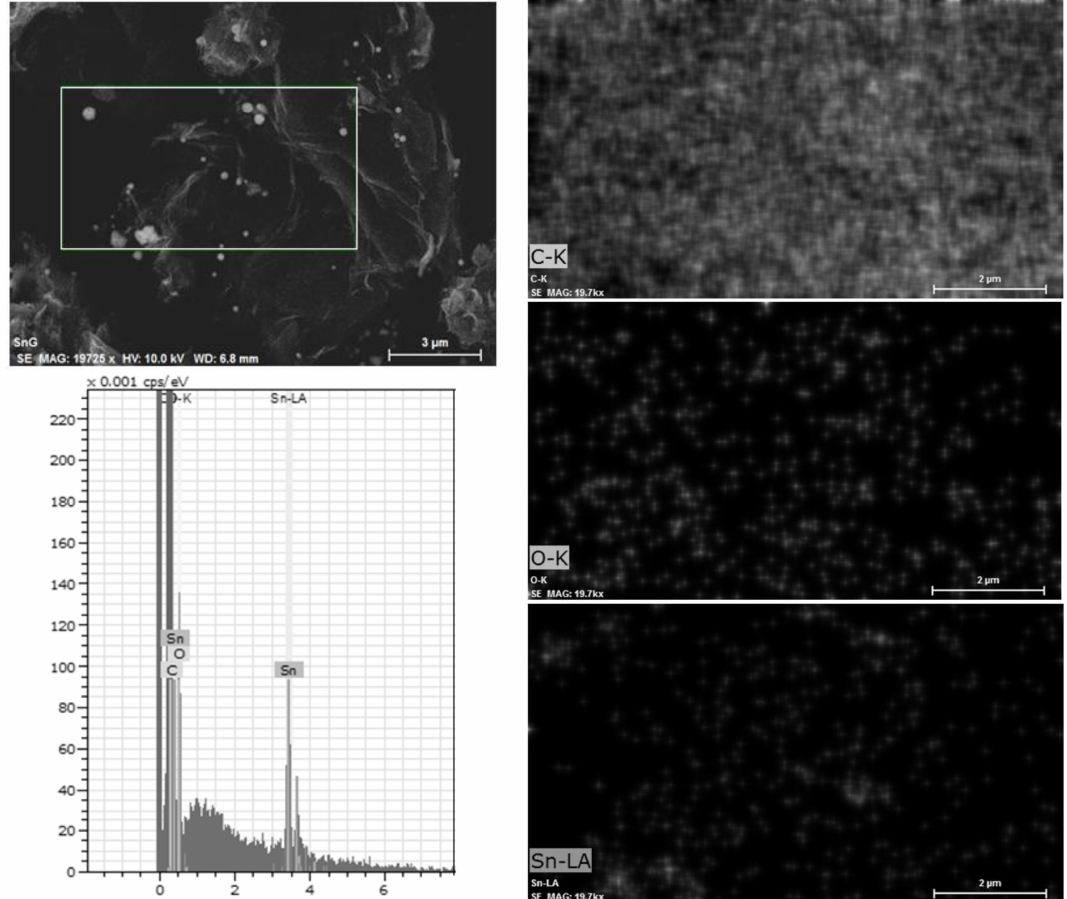
Figure 2. Upper left: Scanning electron microscopy (SEM) micrograph of the Sn-RGO; the rectangle bordered by the white line delimits the area where the EDS analysis was conducted. Lower left: EDS spectrum showing the presence of carbon, oxygen, and tin. Upper right: the white spots mark the presence of carbon. Center right: the white spots mark the presence of oxygen. Lower right: the white spots mark the presence of tin.